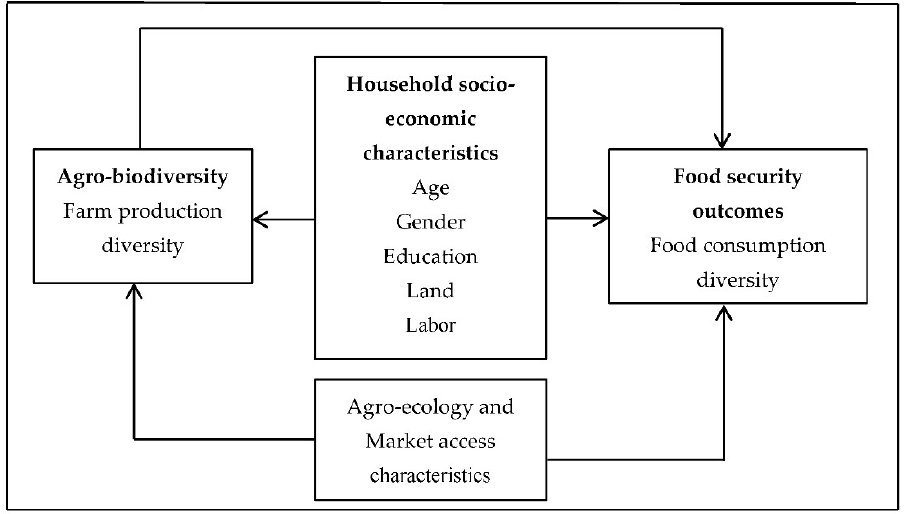
Figure 1. Conceptual framework (Authors’ construction based on KC et al. [11]).